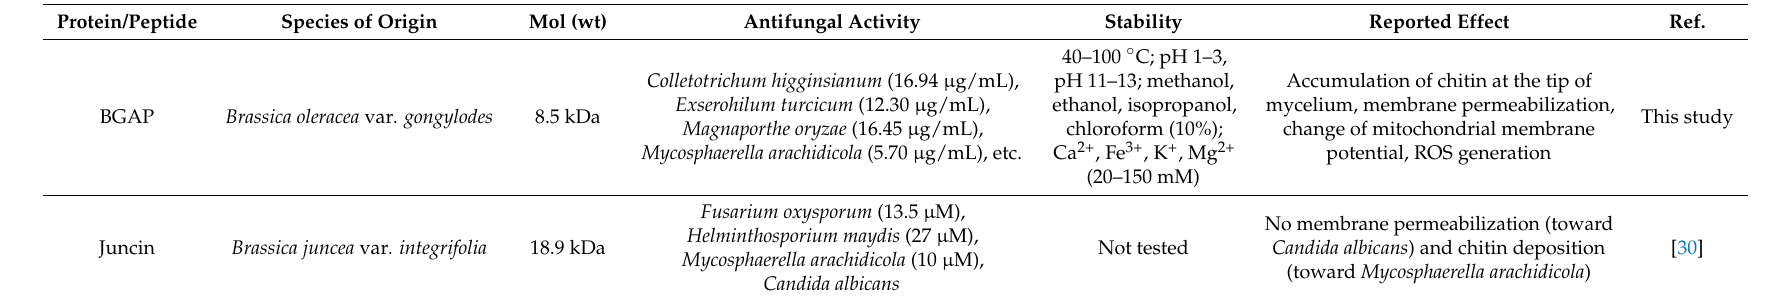
Table 3. Comparison of characteristics of BGAP with antifungal proteins and peptides isolated from Brassica